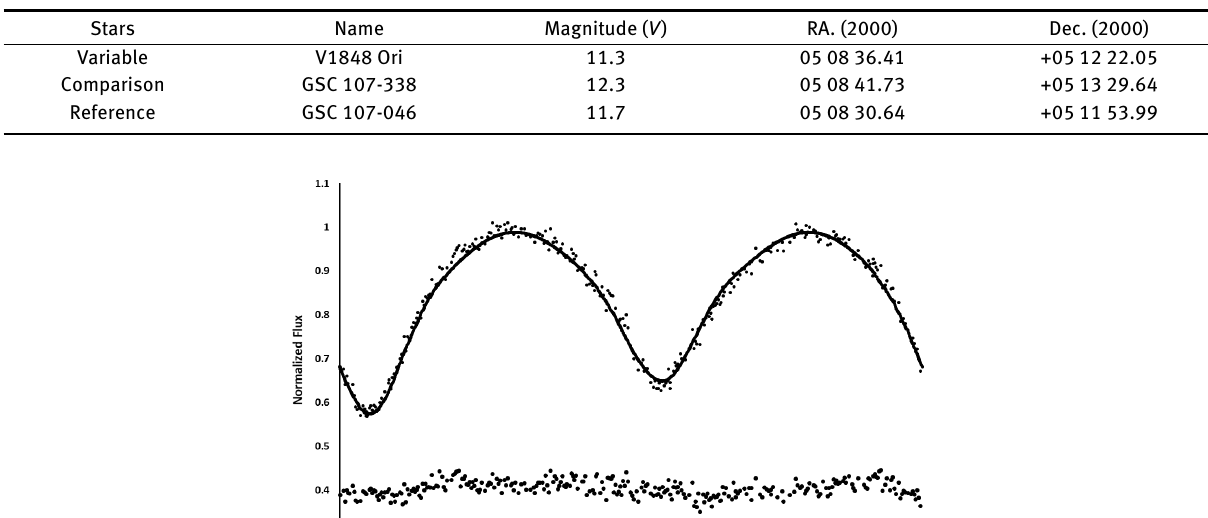
Table 1. Characteristics of the variable, comparison and reference stars (SIMBAD * query result V1848 Ori).¹